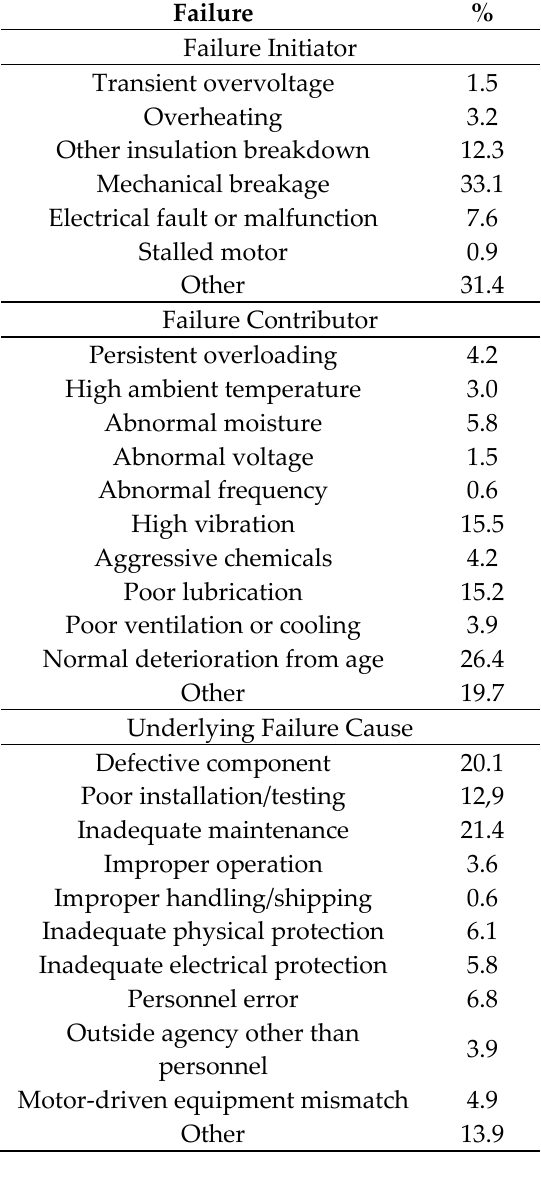
Table 5. Failures according to the severity